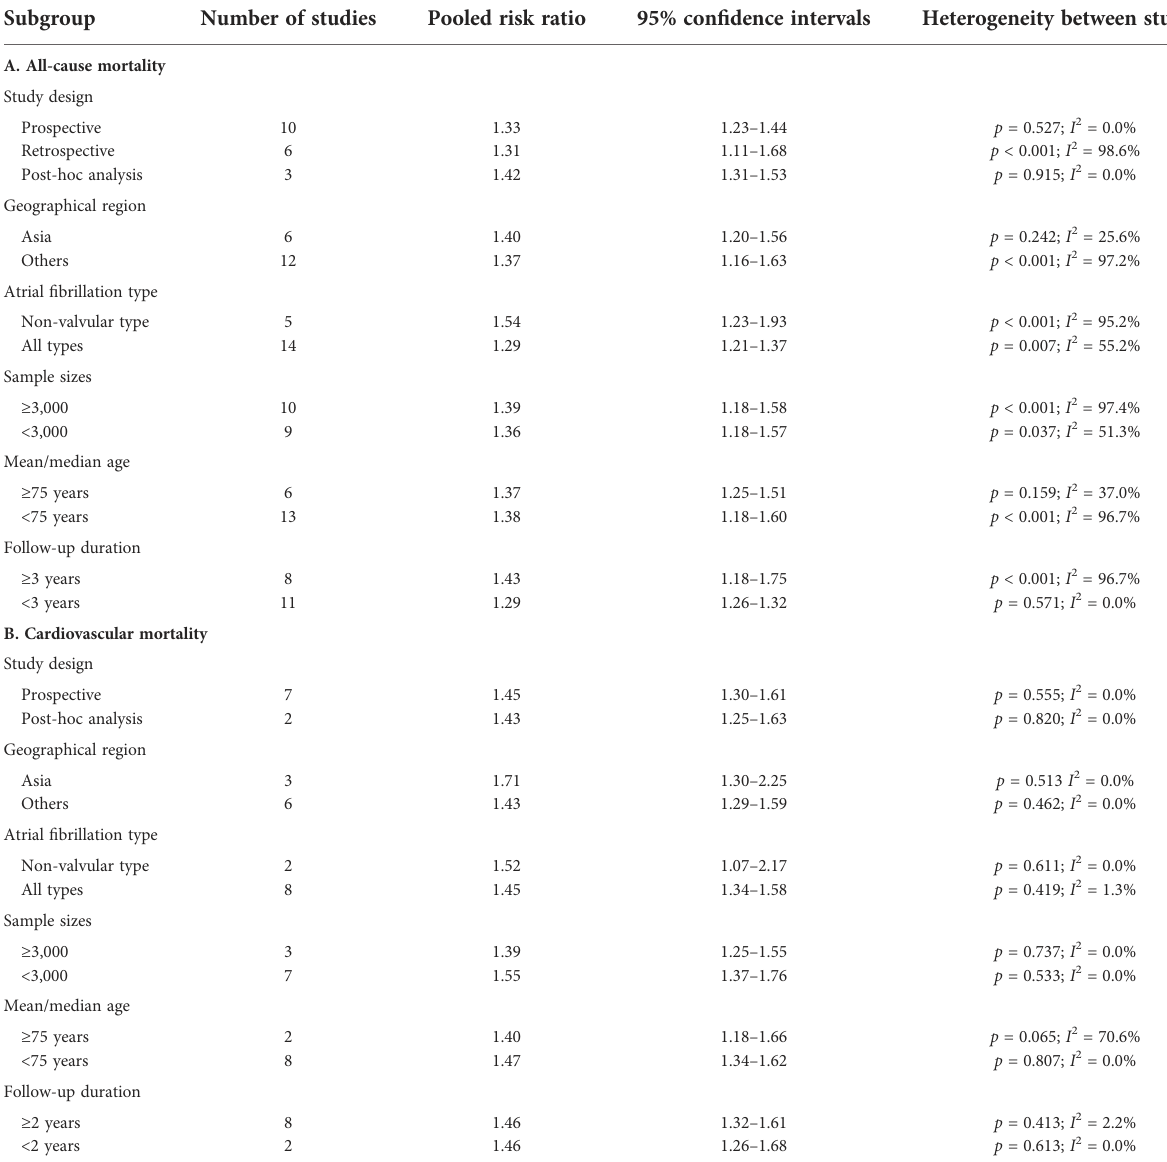
TABLE 2 Subgroup analyses on all-cause (A) and cardiovascular (B)